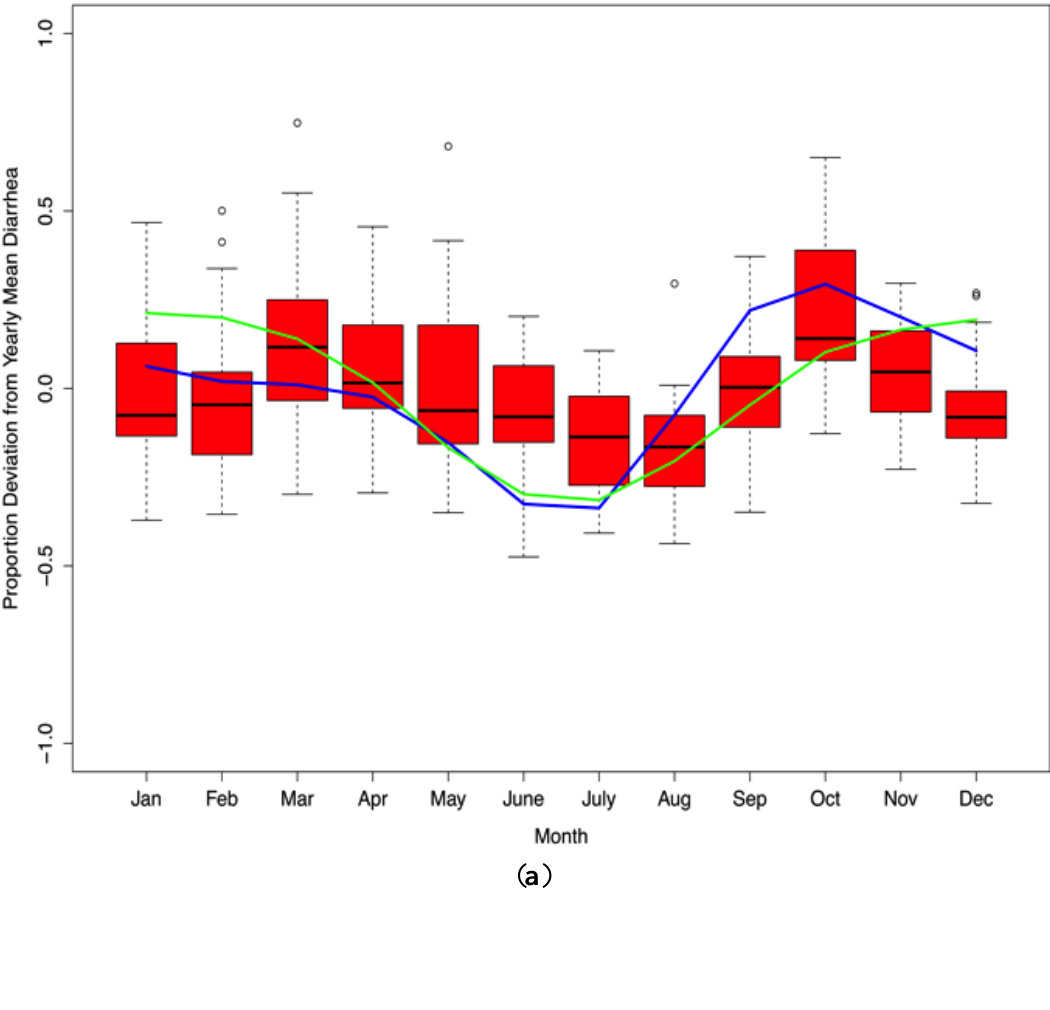
( a ) Standardized minimum temperature (green line) and minimum temperature/vapor pressure (blue line) are plotted over diarrhea case incidence presented as a proportion deviation from yearly mean diarrhea cases (red box plot). ( b ) Standardized rainfall (orange line) and vapor pressure (purple line) are plotted in a similar manner with diarrhea cases. Together, these meteorological variables act as strong predictors of average monthly diarrhea in Botswana